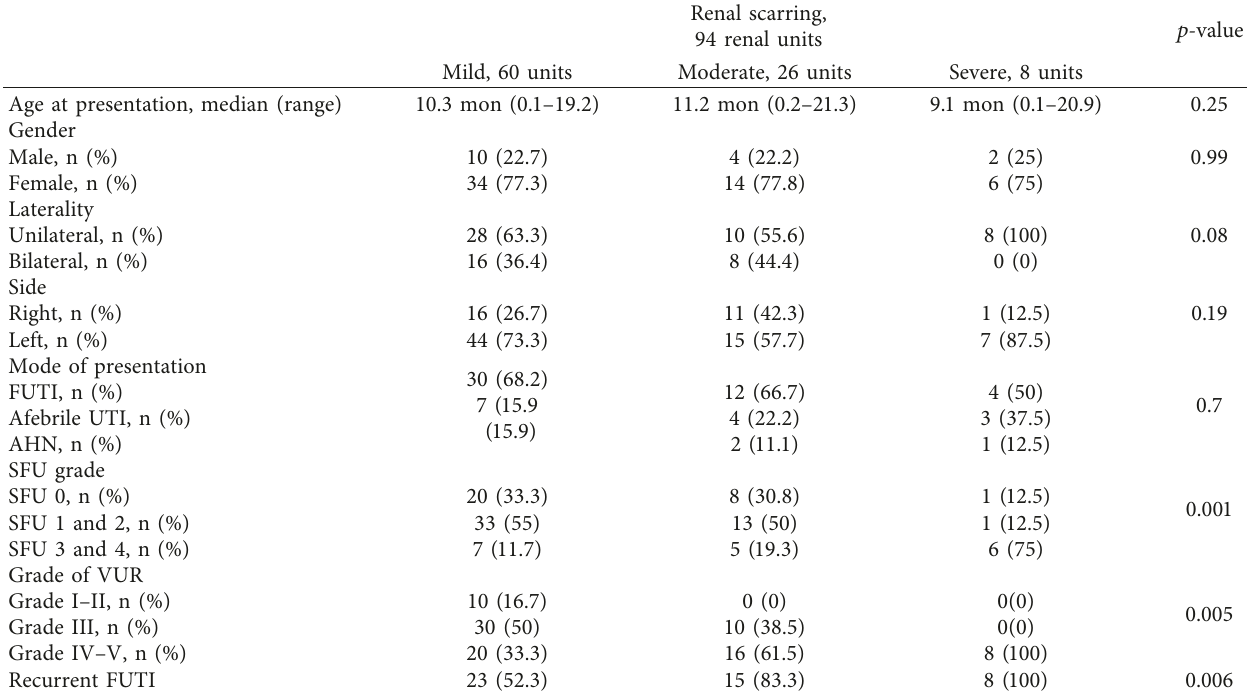
Table 2: Distribution of patients with degree of renal scarring Renal